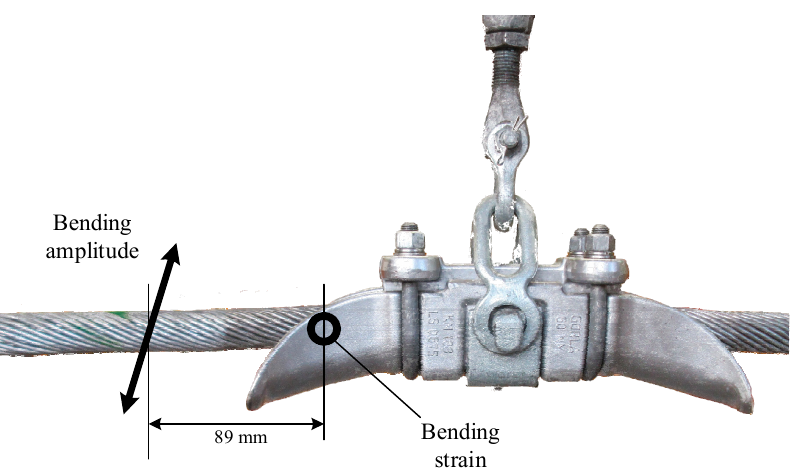
Figure 2. Representation of the main parameters at the basis of the bending amplitude method.